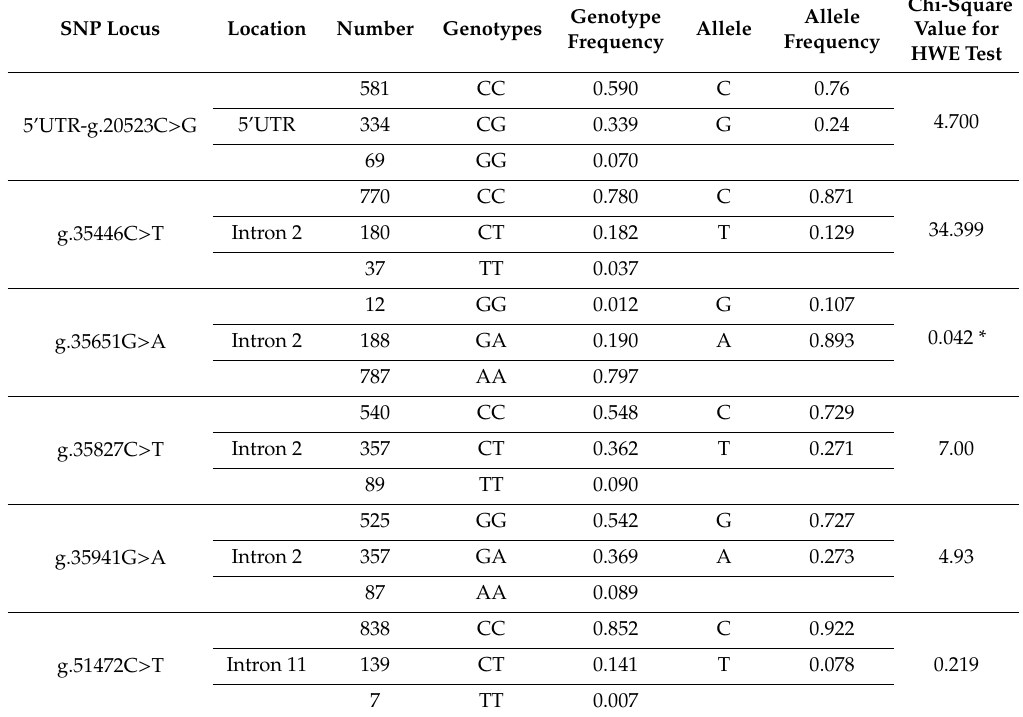
Table 2. Genotypic and allelic frequency, and values of chi-square test significance for SNPs of ACSL1 genes in Chinese Holstein cows.